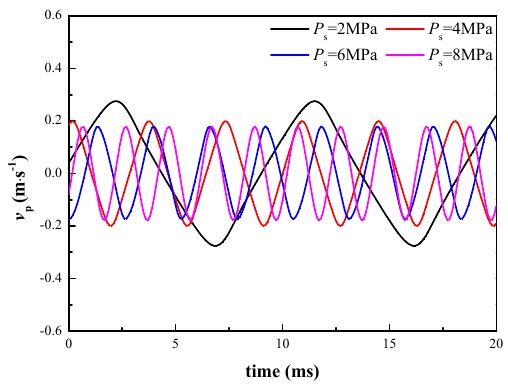
Figure 13. Displacements of different supply pressures.